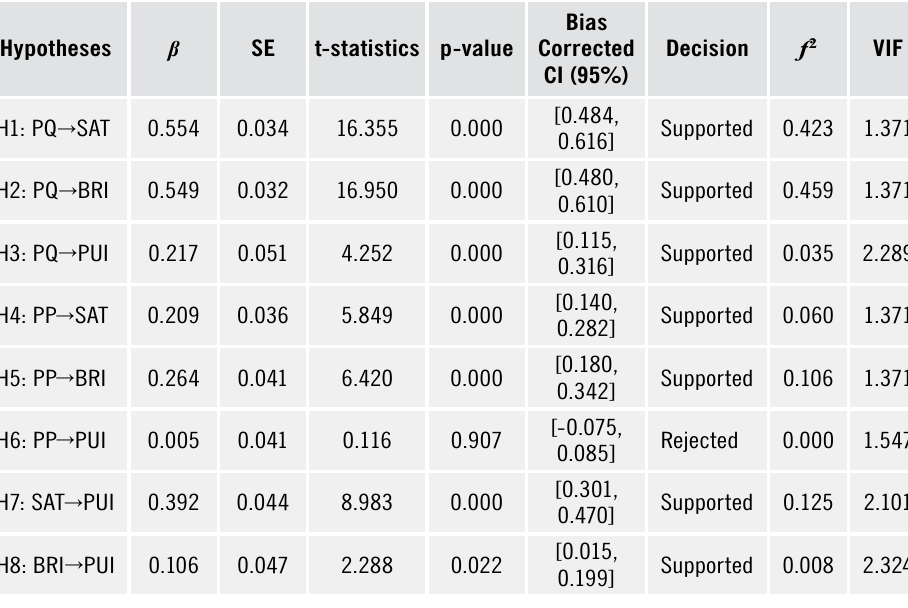
Figure 2. Structural model output from SmartPLS 3.3.2